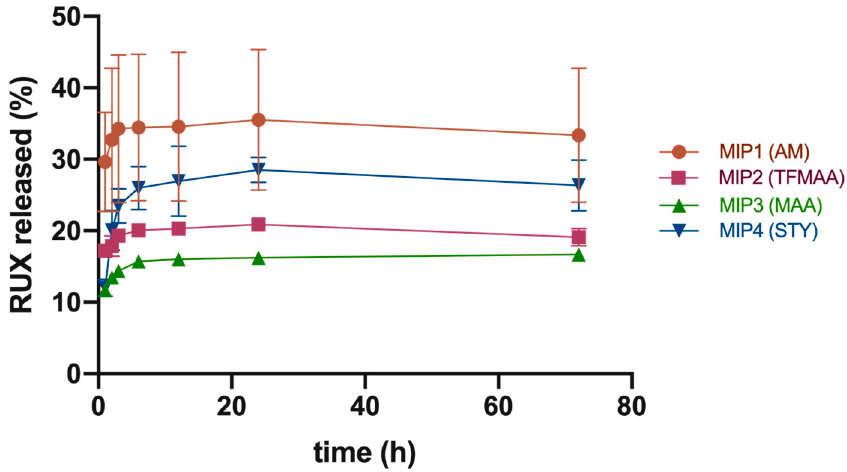
Figure 9. Cumulative drug release at pH = 5.5 in PBS + SDS 2%.